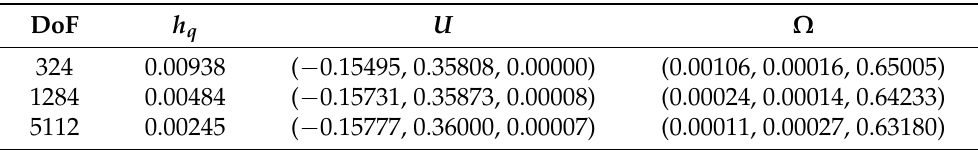
Table A1. Convergence of the numerical solution of the swimming problem for three discretisa- tion levels, for the most slender swimmer with a 0 = 0.02.